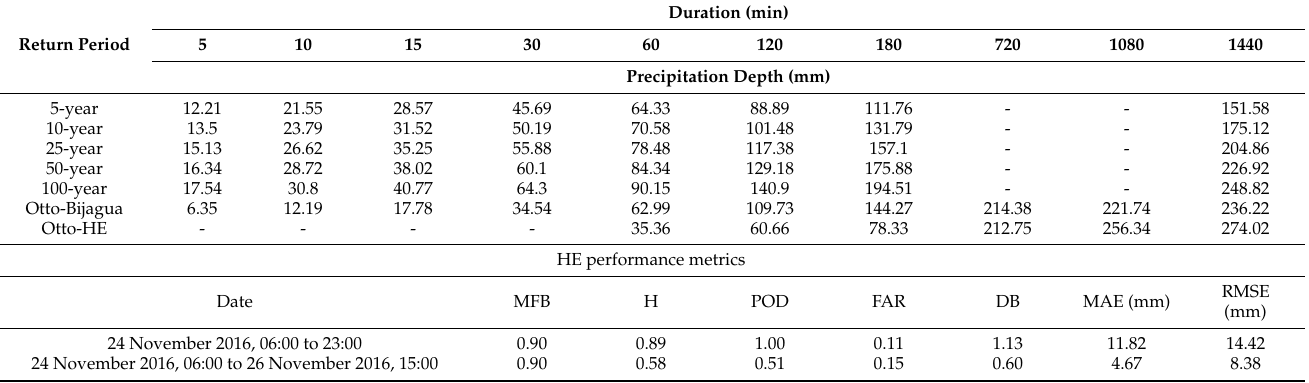
Table 3. Depth–Duration–Frequency for Bijagua’s rain gauge, maximum rainfall depths for Otto measure by rain gauge and HE and HE performance metrics.